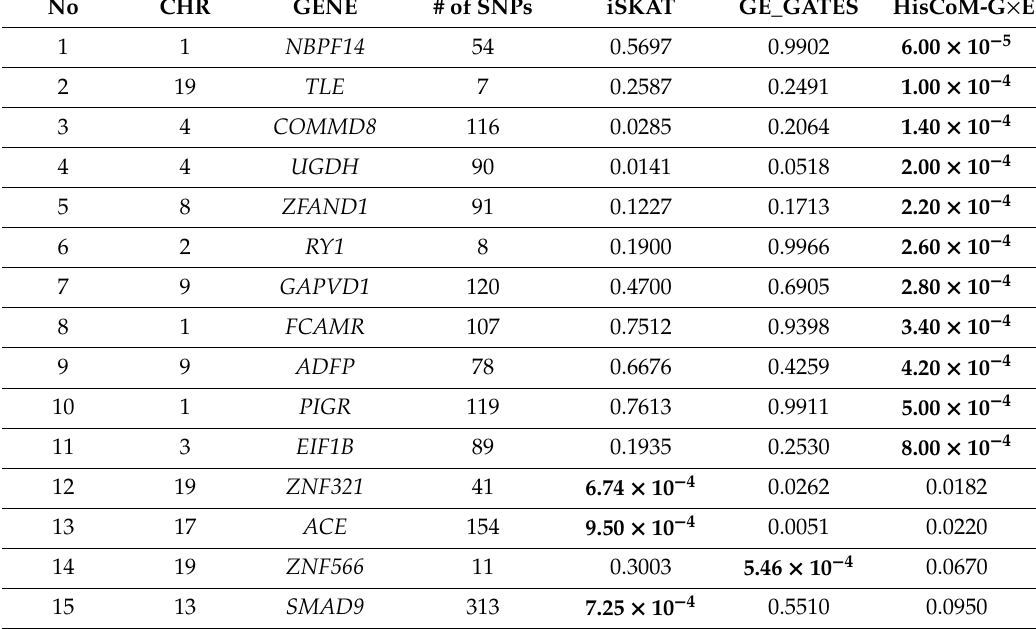
Table 1. Significant ( p < 0.001; bold) gene–environment interactions that a ff ect systolic blood pressure (SBP), according to the interaction sequence kernel association test (iSKAT), the gene–environment gene-based association test using extended Simes (GE_GATES), and HisCoM-G × E, using the Korea Associated REsource (KARE) genome-wide association studies (GWAS)